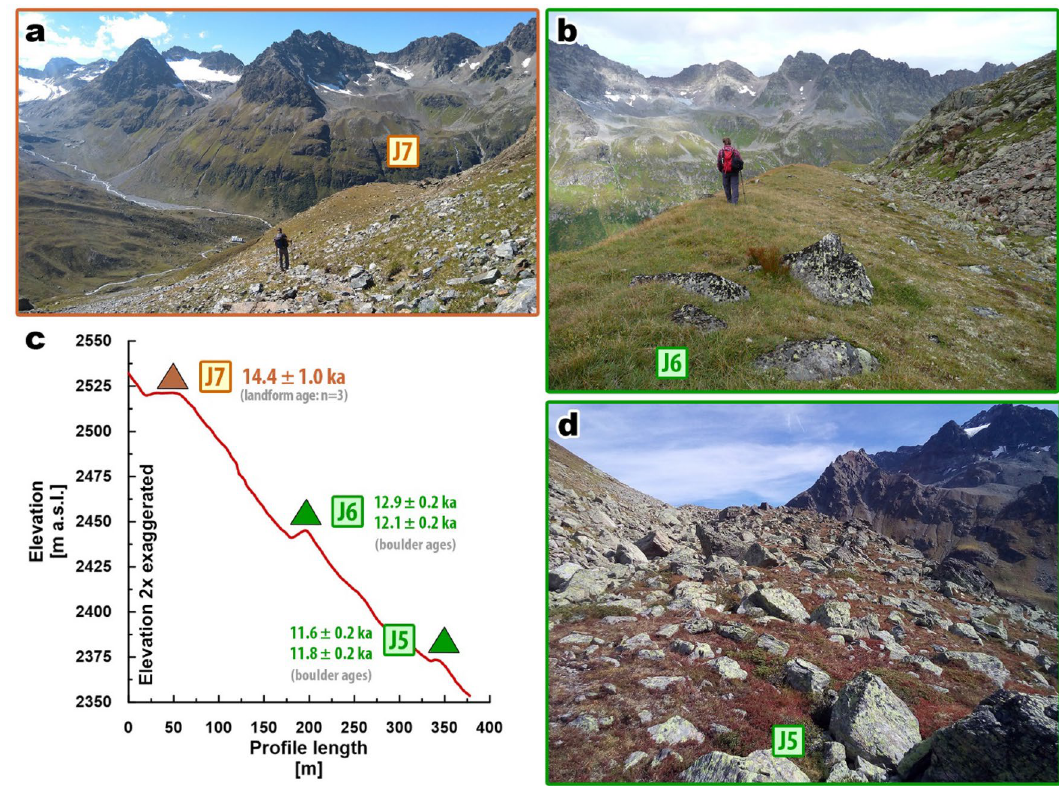
Figure 4. Closeups of dated moraines (a) J7, (b) J6 and (d) J5 highlight different geomorphological characteristics of the three landforms. (c) Profile along LG valley flank (for location, see Fig. 3b) indicating ice surface positions at different times during the